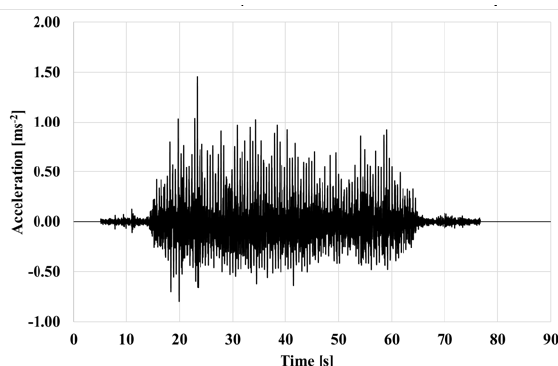
Figure 8. Maximum platform acceleration in 2015 [6].